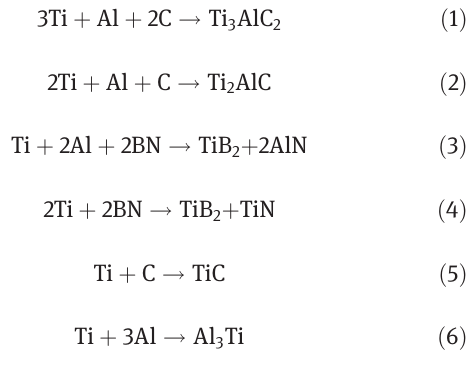
Figure 2. The main product phases of the sample were